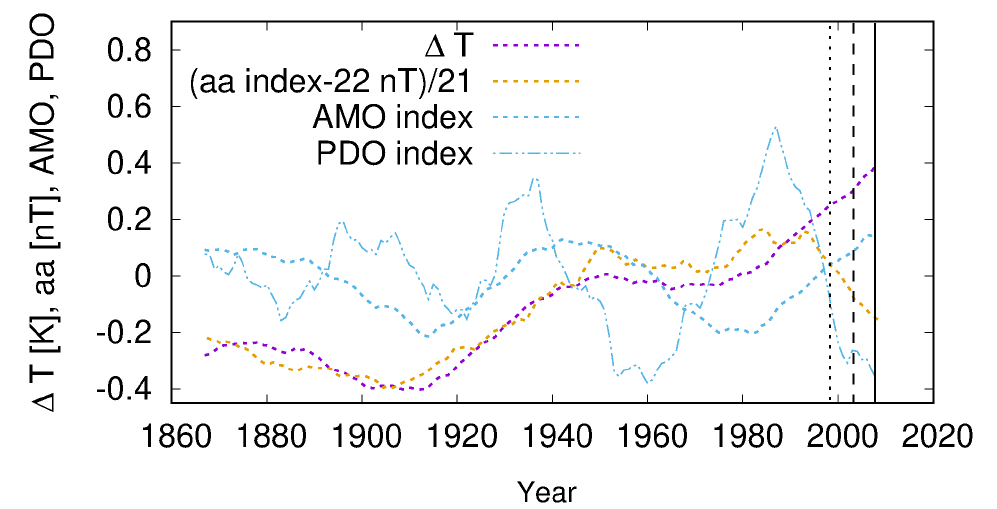
Figure 2. Comparison between the centered moving averages over 23 years of the four datasets ∆ T , aa index, AMO index and PDO index. Note the remarkable parallelity of ∆ T and aa index until 1990, and the divergence thereafter. The AMO index also has some similarity with ∆ T , while the PDO index is significantly different. The AMO index data were obtained from https://psl. noaa.gov/data/timeseries/AMO/ (accessed on 17 December 2020), the PDO index data from